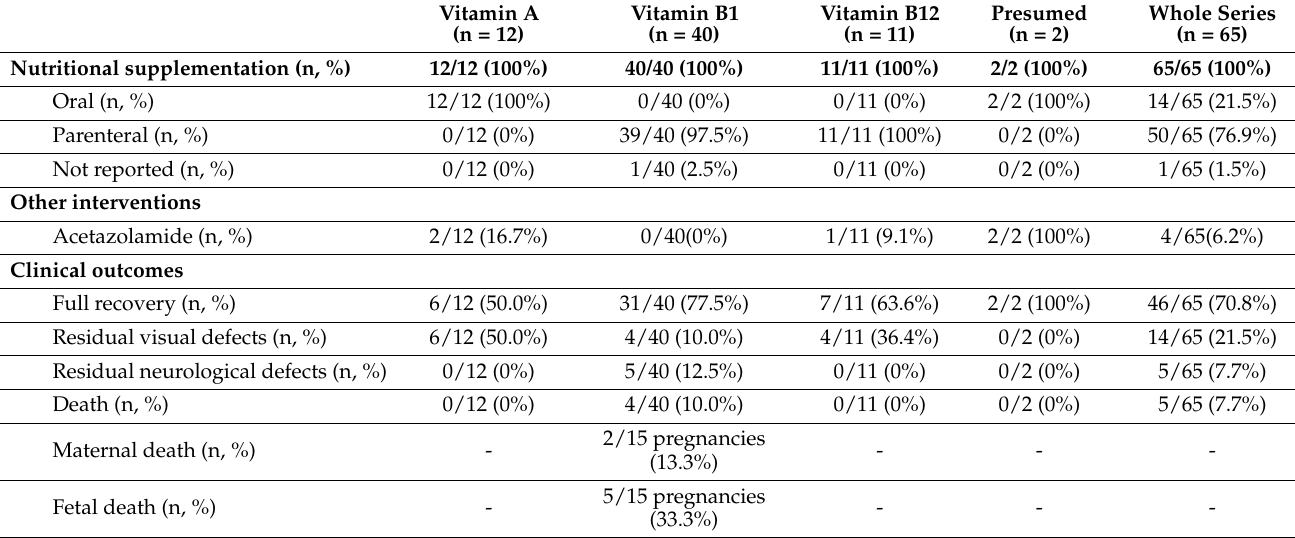
Table 4. Therapeutic interventions and